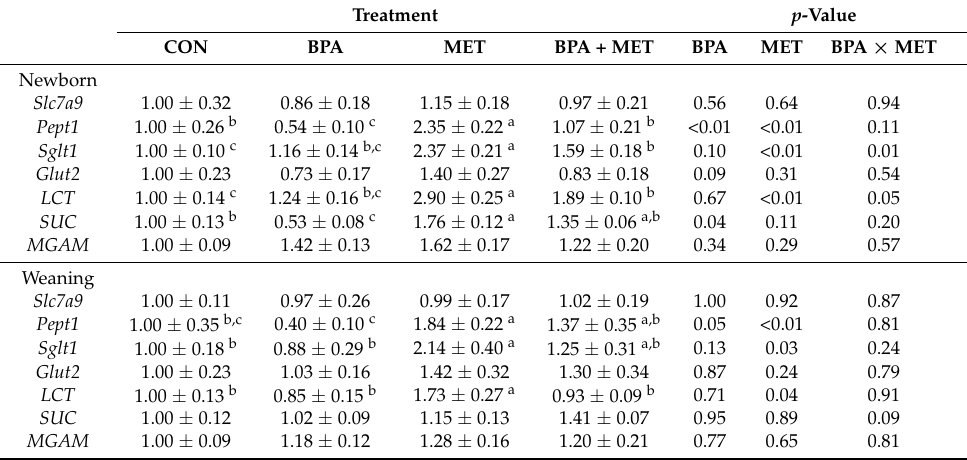
Table 7. Effect of maternal methyl donor or bisphenol A supplementation during gestation on mRNA relative expression of nutrient transporters and disaccharidases in jejunum of newborn and weaning piglets.